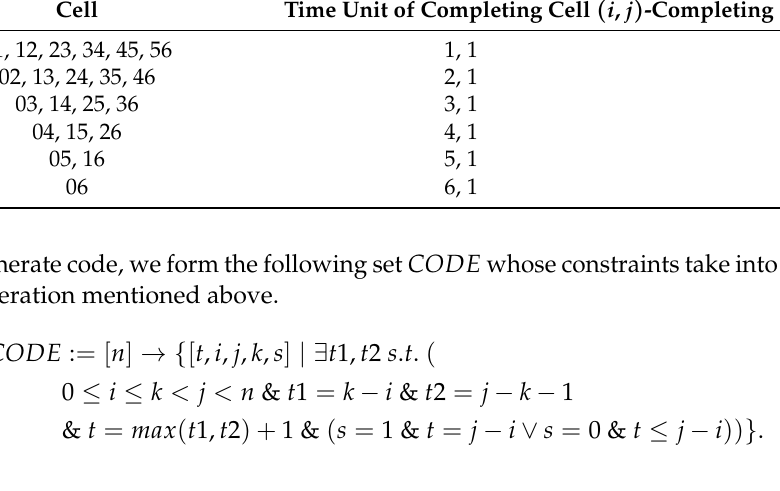
Table 2. Time units of the completion of all cells—the completion of S2.